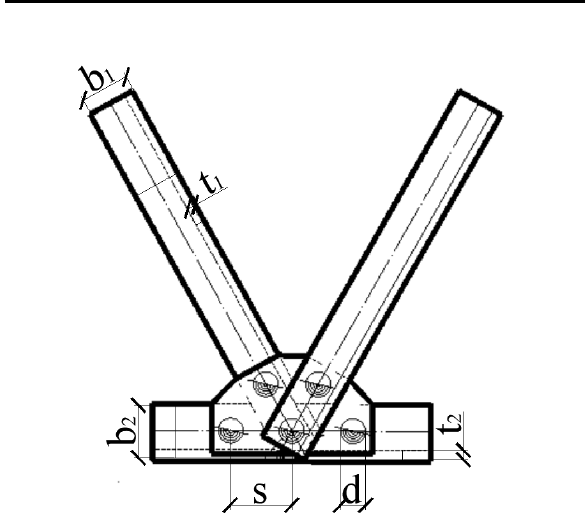
Figure 12: Comparison between formula calculation moment rota- tion curve and numerical simulation result and M u of the example model is calculated by Eq. (6) and Eq. (7). The value of K is 247.81 kN·m/rad, and the error between the formula result and the numerical simulation result is 4.4%. M u is calculated to be 1.30, and the error is 1.5%. The value of n is calculated by Eq. (8). The moment- rotation curve of the example model is established with the results of formulas, and it is compared with the numerical simulation result, which is shown in Figure 12. It is seen that the curve by formula results agrees well with the nu- merical one. The average error of the data is 5.04%, and the accuracy of these equations is high. So the moment-rotation curve can be established directly by Eq. (3) to Eq. (8) with model parameters, which is much easier than the way of a building refined finite element